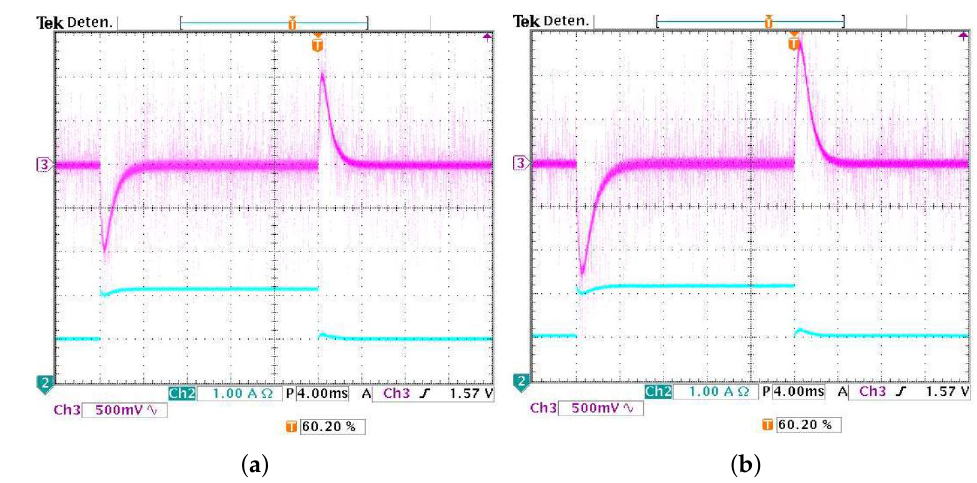
Figure 14. Experimental response of the boost converter under input voltage transients of 2 V with the LMI-Fuzzy controller ( F LMI − Fuzzy ) and LMI robust Controller ( F LMI ). ( a ) Voltage response v o with F LMI − Fuzzy . ( b ) Voltage response v o with F LMI [9].